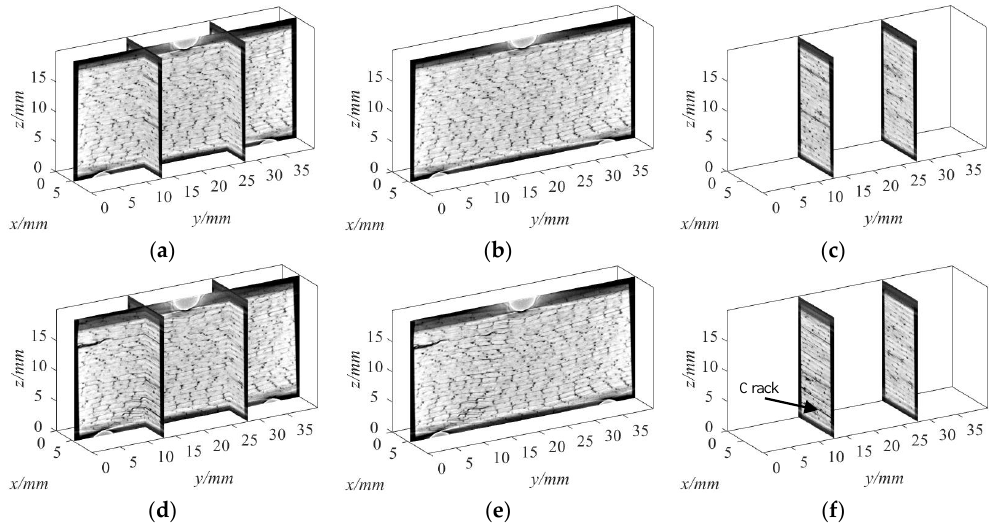
Figure 9. Reconstructed sectional images: ( a ) One middle longitudinal sectional image and two transverse sectional images of step 10; ( b ) The middle longitudinal sectional image at x = 4.5 mm of step 10; ( c ) two transverse sectional images of step at y = 11.925 and 27.000 mm of step 10; ( d ) One middle longitudinal sectional image and two transverse sectional images of step 11; ( e ) The middle longitudinalsectional image at x = 5.625 mm of step 11; ( f ) two transverse sectional images of step at y = 11.925 and 27.000 mm of step 11. In Figure 10, v , w displacement fields and ε yy , ε zz and ε yz strain fields of the middle longitudinal sectional image at step 7 (F = 6761 N), step 9 (F = 8333 N), and step 10 (F = 8982 N) are depicted,